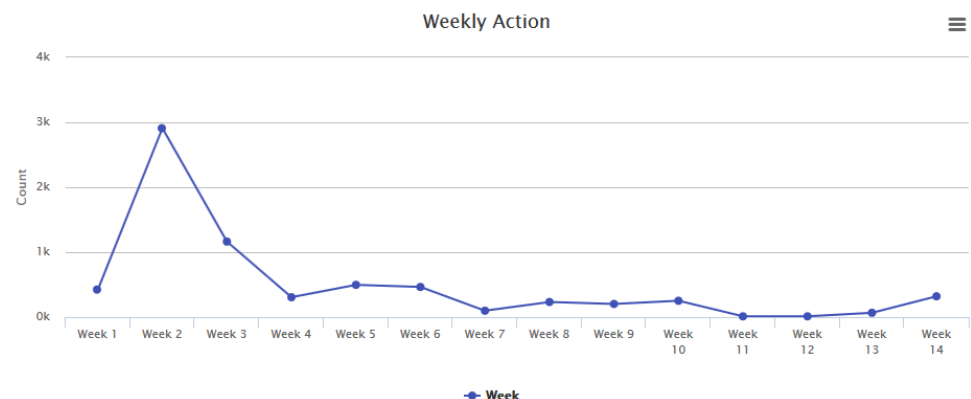
Figure 9. Total weekly